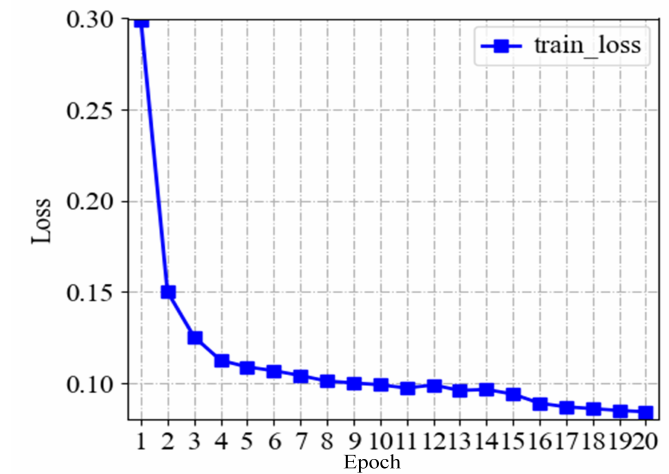
Figure 10. Loss value of training set.